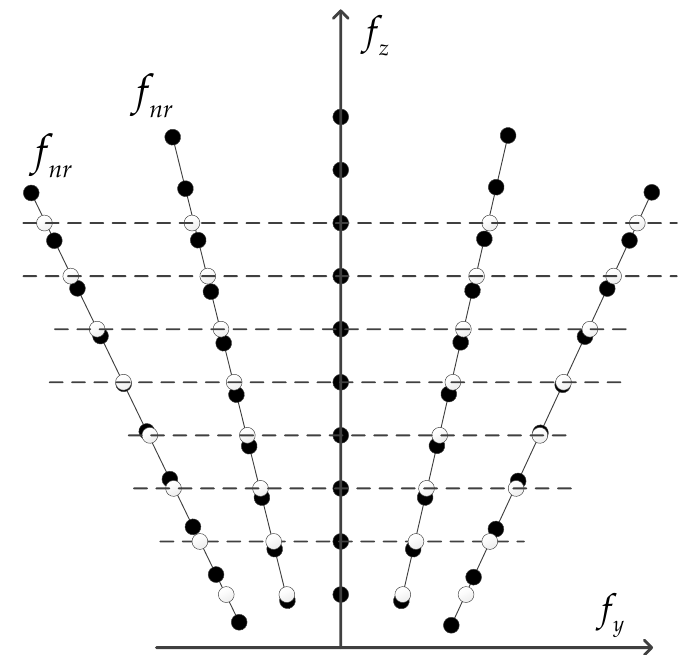
f in the echo of each array element is constant. z